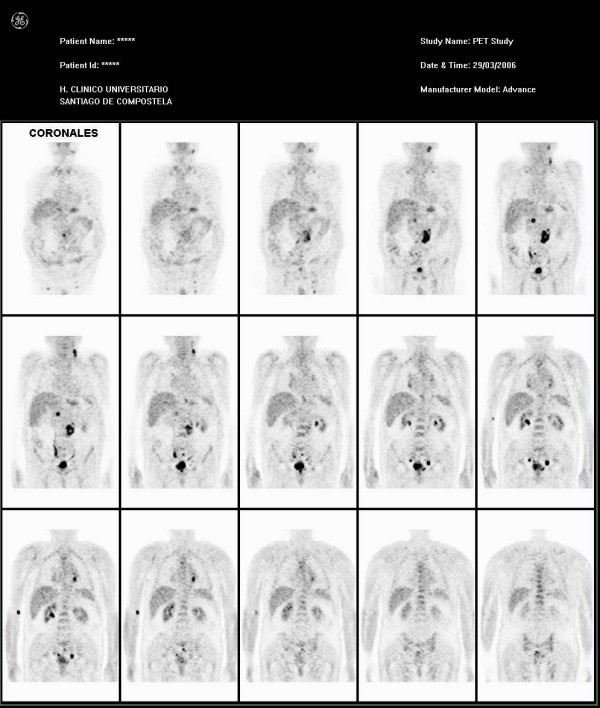
Coronal view shows multiple areas of increased metabolism affecting the neck, mediastinum, left suprarenal gland, abdominal lymph nodes and the bladder.